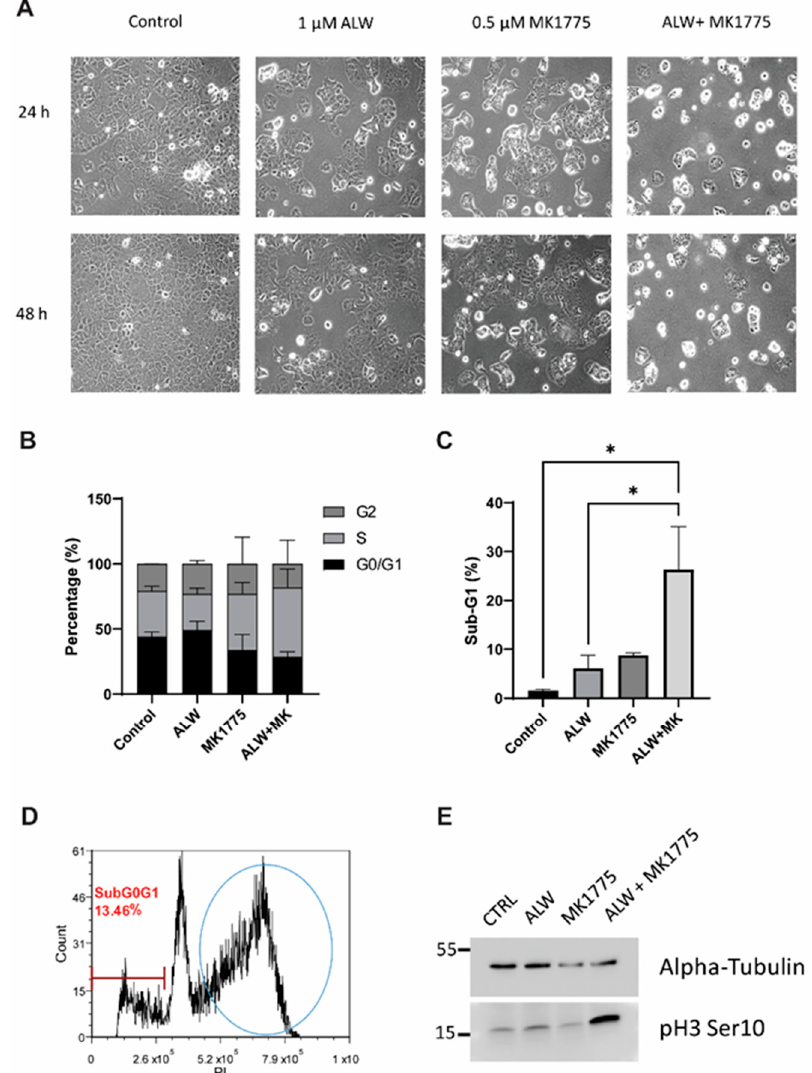
Figure 2. Effects of combination therapy on cell proliferation. ( A ) Cell morphology images of untreated (control) and ALW- and MK1775-treated Hec1A cells at 24 h and 48 h timepoints. ( B , C ) Flow cytometry analysis of cell cycle phases in Hec1A cells that were untreated or treated for 48 h. ( D ) Cell cycle profile of ALW- and MK1775-treated cells showing cells arrested between the S and G2 phases. ( E ) Western blot analysis for phosphorylated histone H3, an indicator of cells arrested in mitosis. Statistics were performed using one-way ANOVA with the Tukey’s post hoc test for multiple comparisons for more than two groups. * p < 0.05.